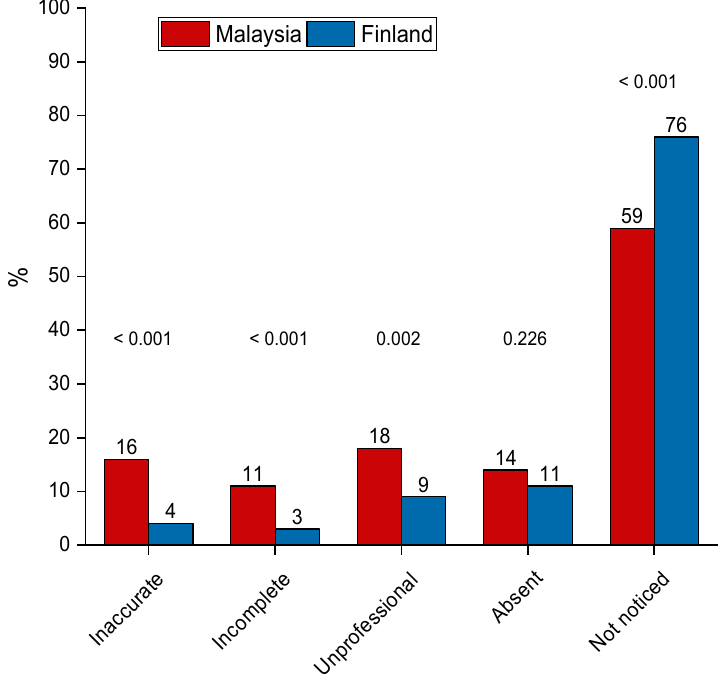
Figure 2. Percentage distributions of responses to the question “Have you ever found that your online presence was any of the following?” Data include dental undergraduate students from Malaysia ( n = 440) and Finland ( n = 203). Statistical significances between countries were evaluated by chi ‐ square test.